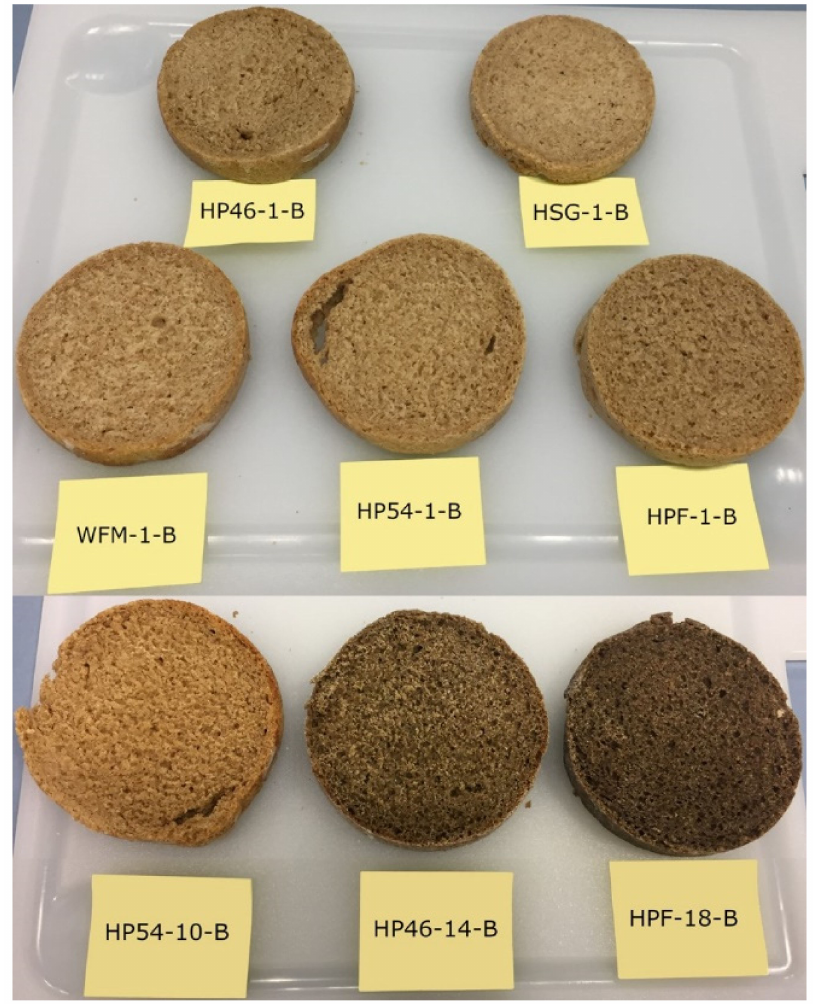
Figure 3. Breads (-B). HSG—hemp seed grit; HPF—hemp press cake flour; HP46—hemp press cake flour protein (46%); HP54—hemp press cake flour protein (54%); WFM—half-and-half mixture of wheat and whole wheat